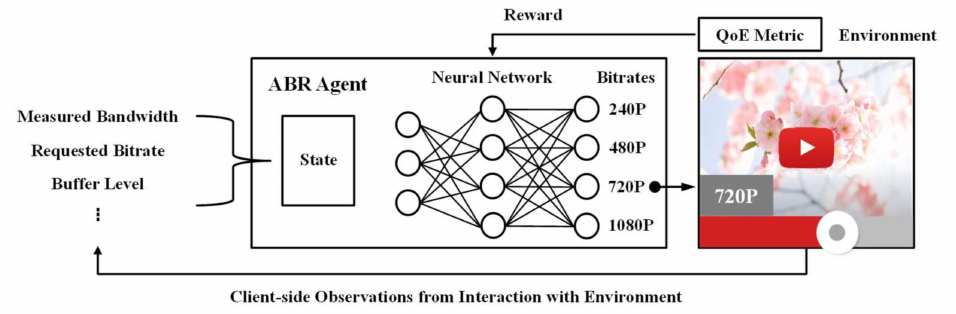
Figure 2. Concept of applying reinforcement learning to bitrate